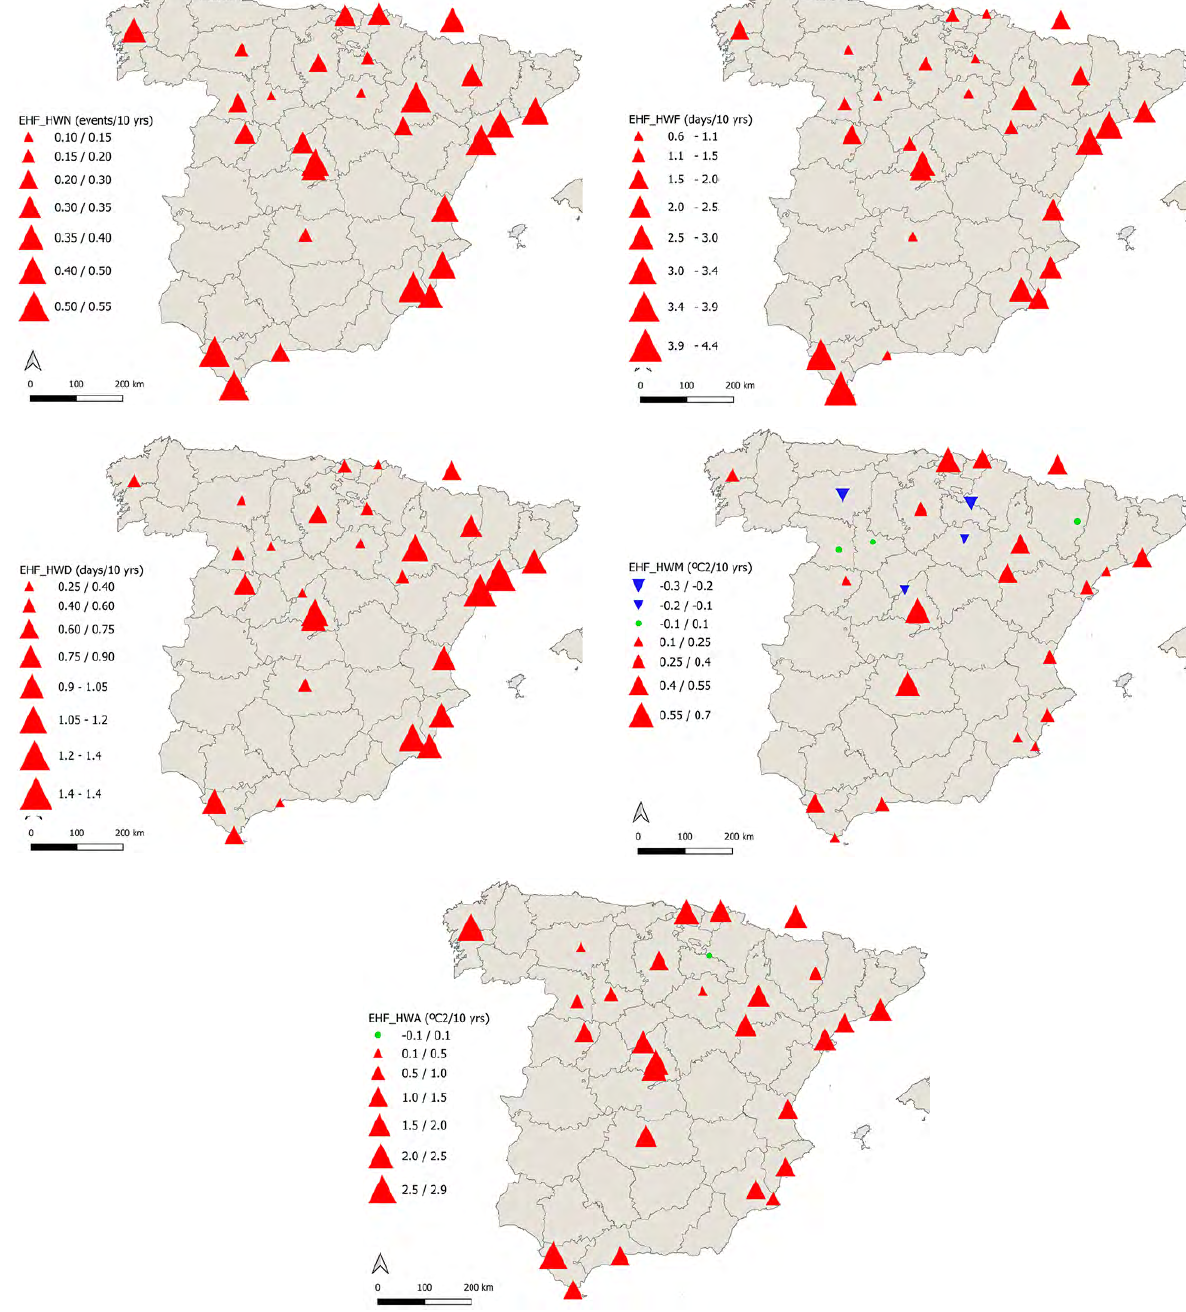
Figure 5. Maps of the spatio-temporal annual trends of the heatwave indices (EHF_HWN, EHF_HWF, EHF_HWD, EHF_ HWM, and EHF_HWA) for the period